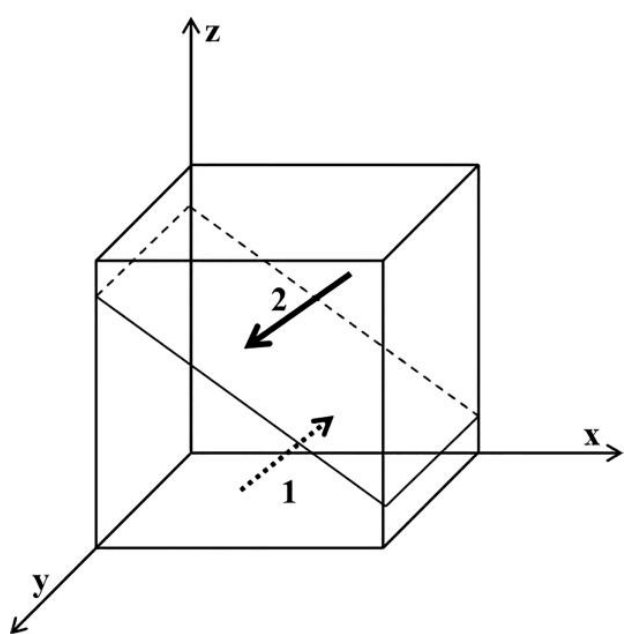
Figure 3. Influence of x on the evolutionary equilibrium stable strategy of y . Region 1 is no increase in production; region 2 is increase in production.